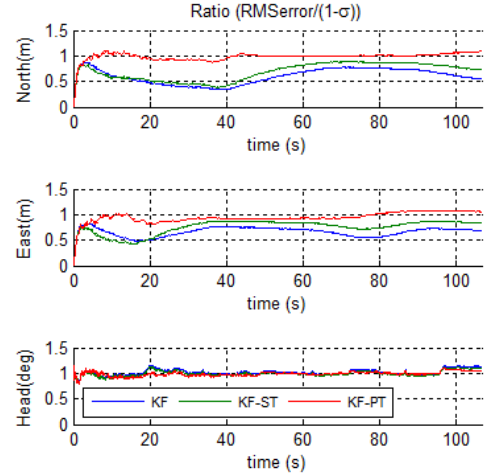
Figure 7. Ratio of RMS errors to estimated standard